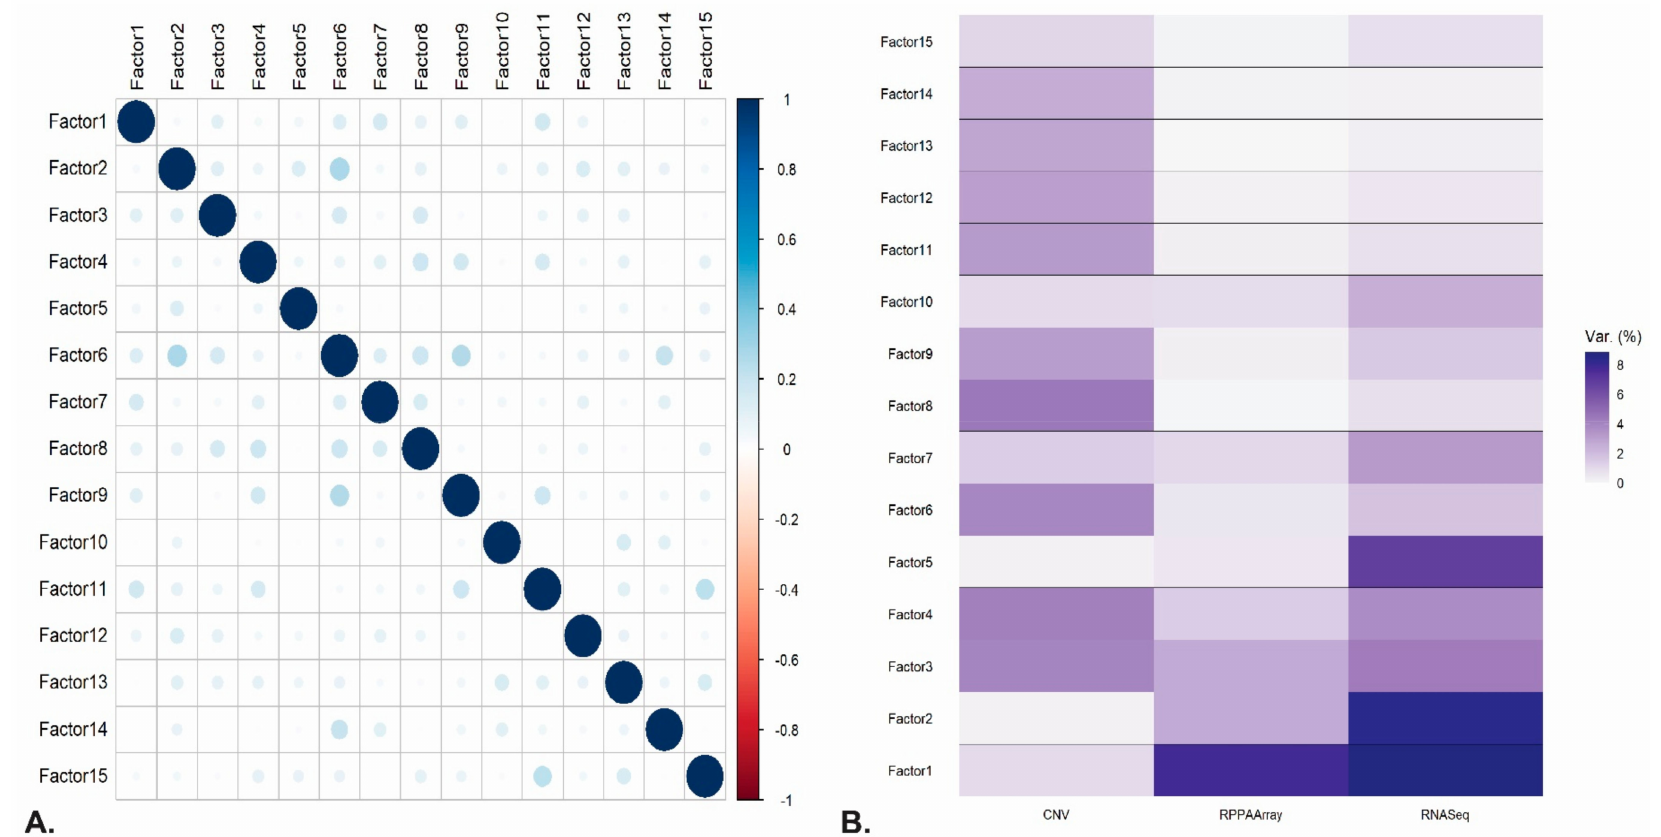
Figure 2. ( A ). Plot of the correlation matrix between the inferred Multi-Omics Factor Analysis (MOFA) latent factors, which can be used as a quality control of the fitted model. It returns a symmetric matrix with the correlation coefficient between every pair of factors. Blue color denotes positive correlation, whereas red negative, respectively. A diagonal correlation matrix is usually expected for a robust model fit, suggesting low correlation overall between the MOFA factors. ( B ). Variance decomposition analysis plot, which illustrates the variance explained (R-squared value) per factor and per layer (CNV, RPPAArray = protein, RNASeq = expression). The values are calculated using a coefficient of determination, which ranges from 0 to 1, and scaled to a percentage by multiplying by